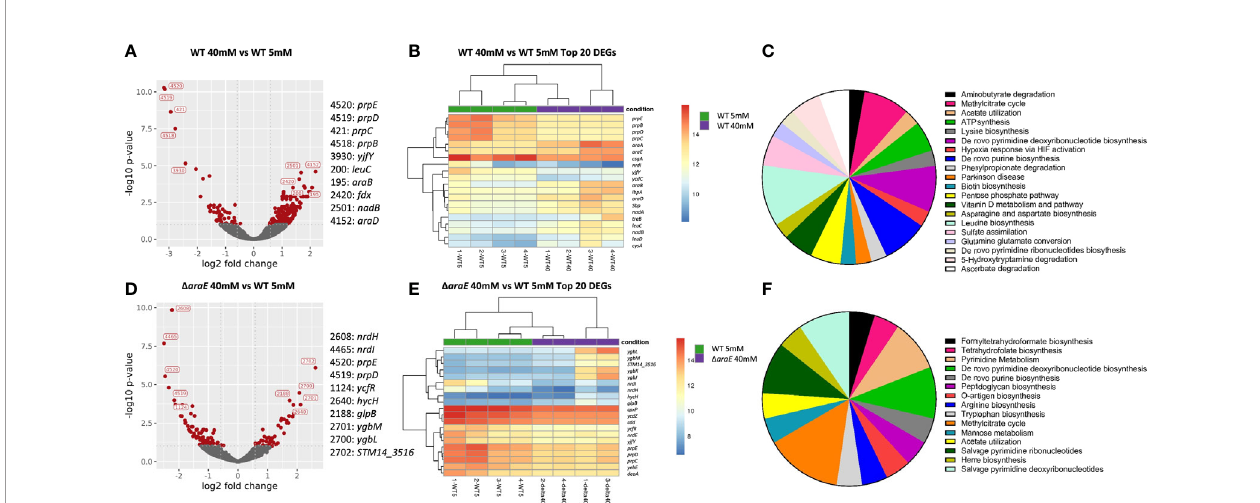
FIGURE 6 | Differentially expressed genes in bio fi lms grown in the presence of L-arabinose. For RNA-Seq analysis, bio fi lms were grown for 4 days in M9 with 5 mM and 40 mM L-arabinose. (A, D) Volcano plots for WT 40 mM versus WT 5 mM and D araE 40 mM and WT 5 mM L-arabinose. The x- axis speci fi es the fold change (FC) and the y- axis speci fi es the negative logarithm to the base 10 of the t test P values. Dashed lines represent the fi ltering criteria (FC ≥ 1.5, P ≤ 0.05). Red dots represent probe sets for transcripts expressed at signi fi cantly higher or lower levels. The top 5 up and down regulated genes are labeled. (B, E) Dendrogram and unsupervised hierarchical clustering heat map (using Euclidean distance) of gene expression based on the log ratio fragments per kilobase per million mapped reads (FPKM) data. Each column represents a biological replicate from each experimental condition; rows represent genes. Red, upregulation; blue, downregulation. The vertical distances on each branch of the dendrogram represent the degrees of similarity between gene expression pro fi les of various groups. (C, F) Pathways of enriched genes in each experimental condition as determined by